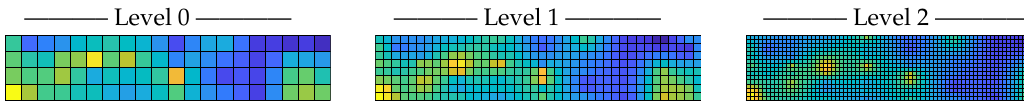
Figure 9. Three realizations of a gamma random field.